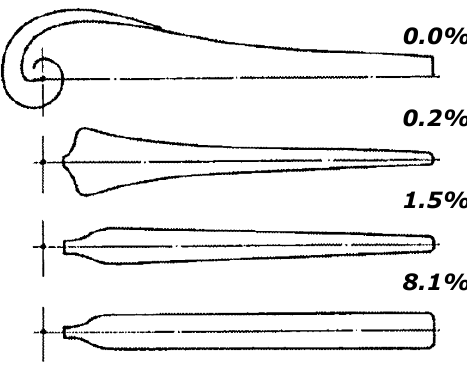
Figure 4. Efficiency losses as a result of simplification to ideal chord length